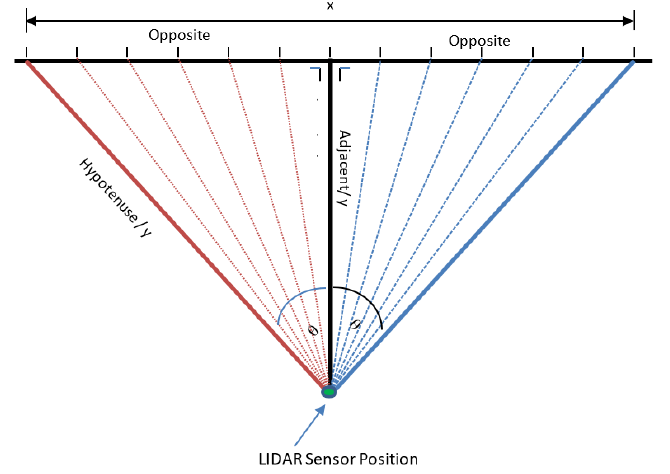
Figure 11. The position of the LiDAR sensor during the scanning process.